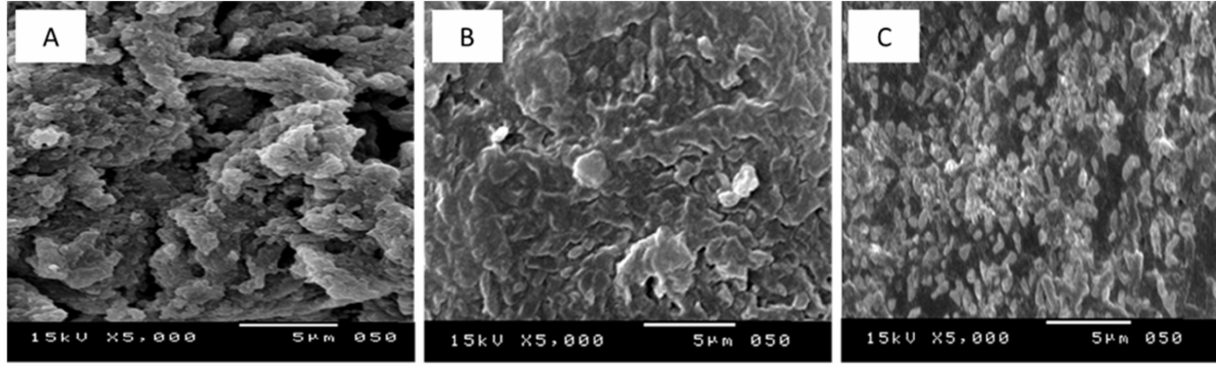
Figure 4. SEM micrographs of ( A ) native exopolysaccharide nEPS, ( B ) gamma-irradiated exopolysaccharide at 1.0 kGy: iEPS–1.0 kGy, ( C ) gamma-irradiated exopolysaccharide at 1.5 kGy: iEPS–1.5 kGy, SEM operating at an accelerating voltage of 15